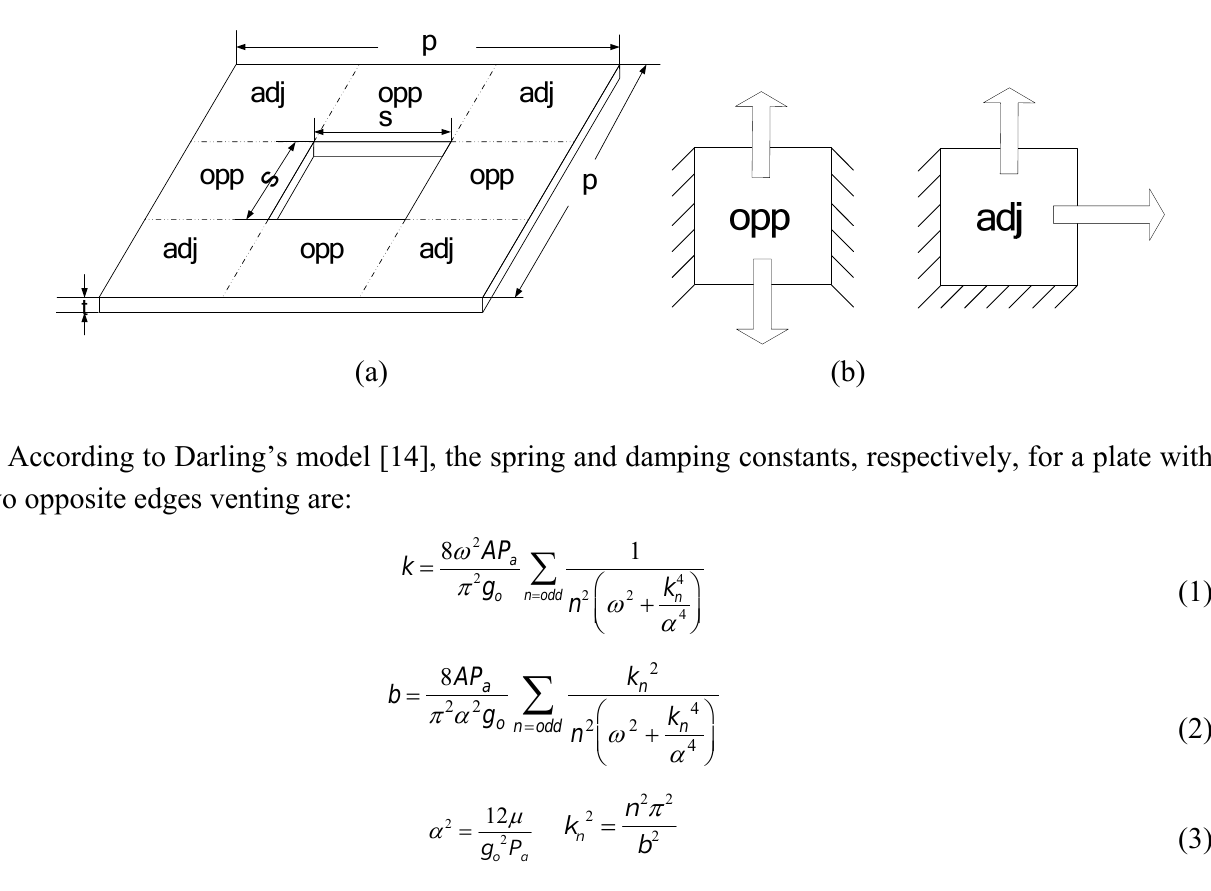
Figure 1. Dividing a plate into elements that can be modeled